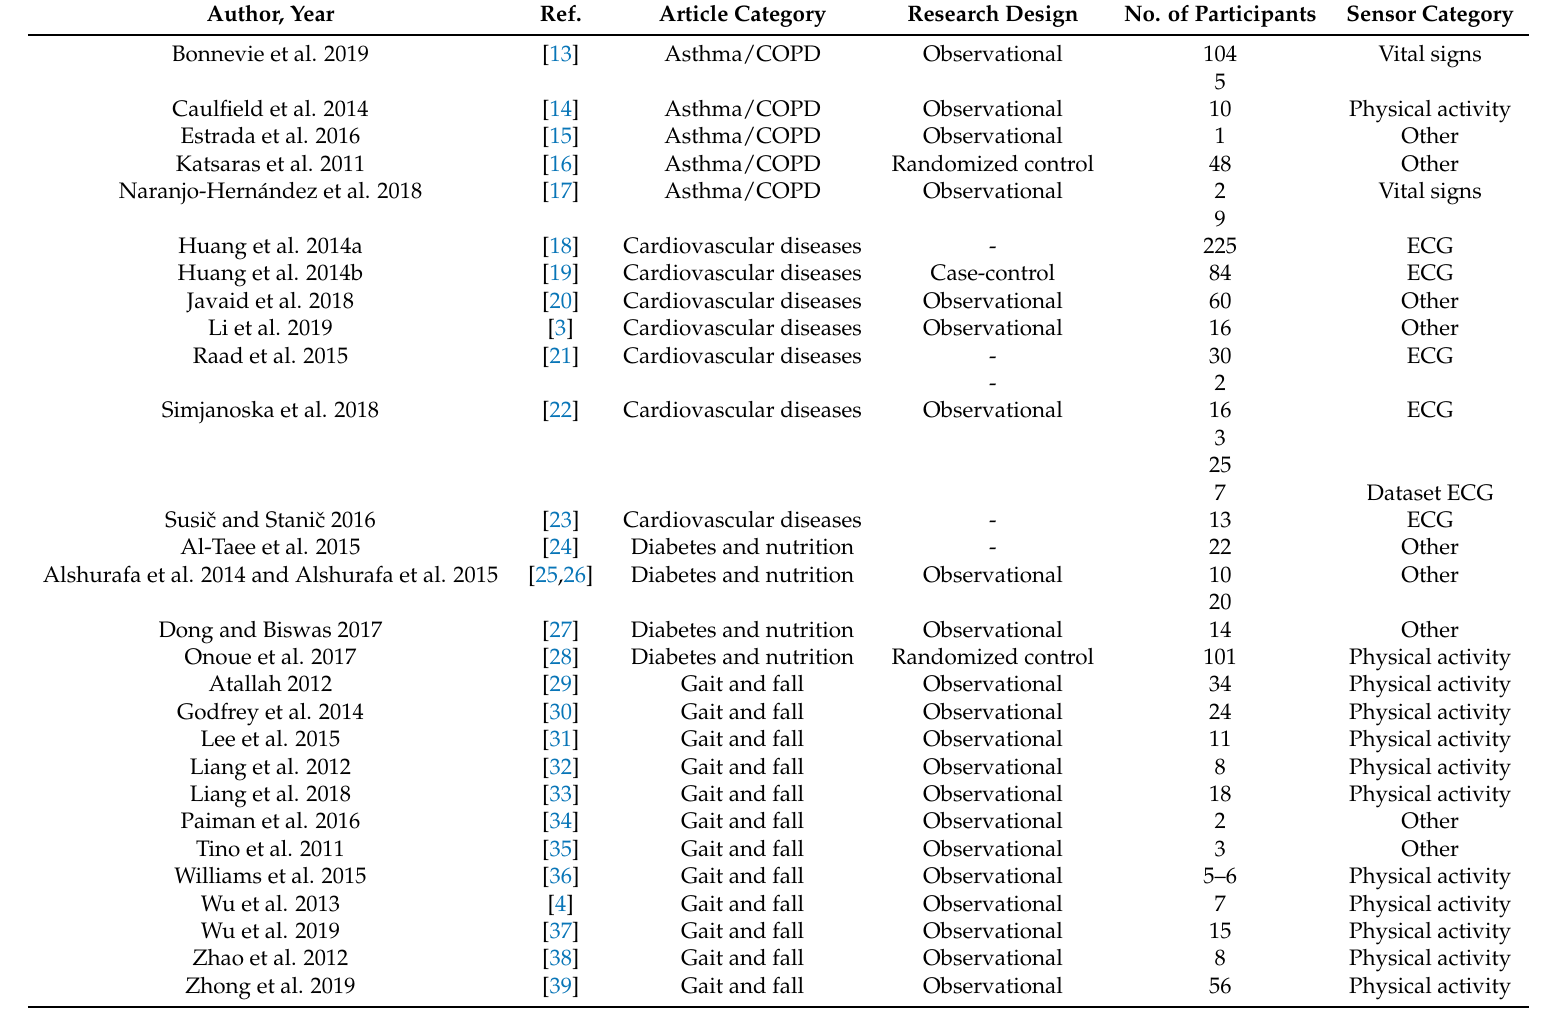
Table 2. List of articles reporting on conducted studies. —indicates that information is